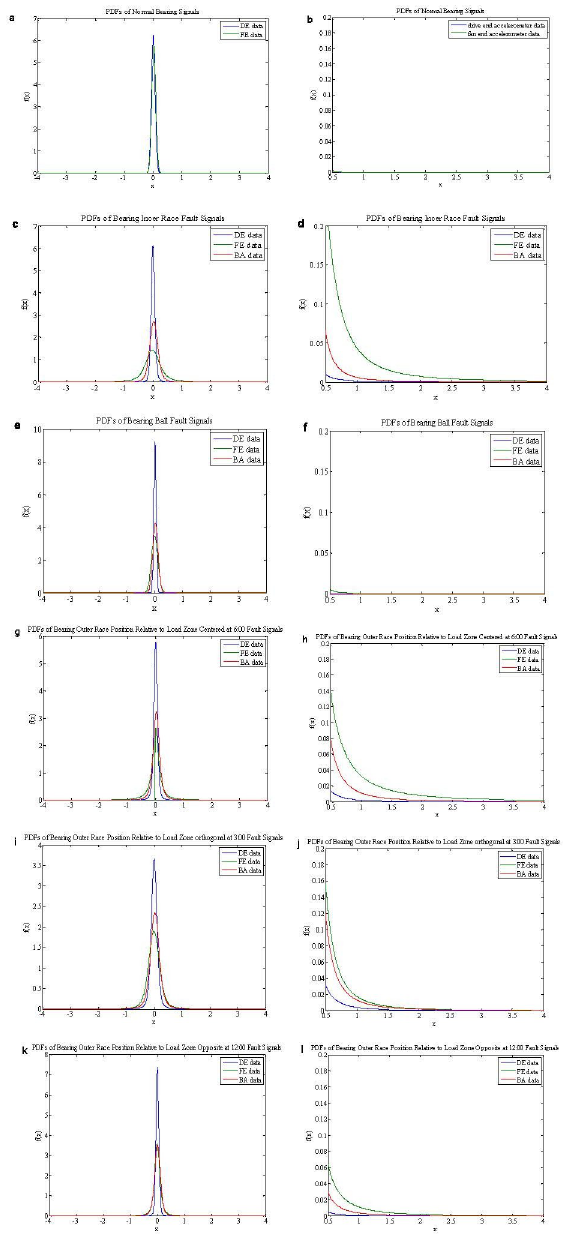
Fig 3. PDFs of the normal data and drive end bearing fault data. (a-b. PDFs of the normal data; c-d. PDFs of the inner race BA, DE and FE fault data; E-F. PDFs of the ball BA, DE and FE fault data; g-h. PDFs of the outer race BA, DE and FE fault data position relative to load zone centered at 6:00; i-j. PDFs of the outer race BA, DE and FE fault data position relative to load zone orthogonal at 3:00; k-l. PDFs of the outer race BA, DE and FE fault data position relative to load zone opposite at